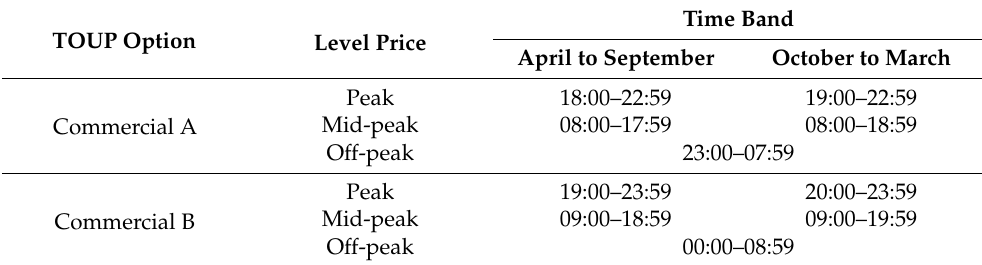
Table 4. Options of time bands and price levels for commercial